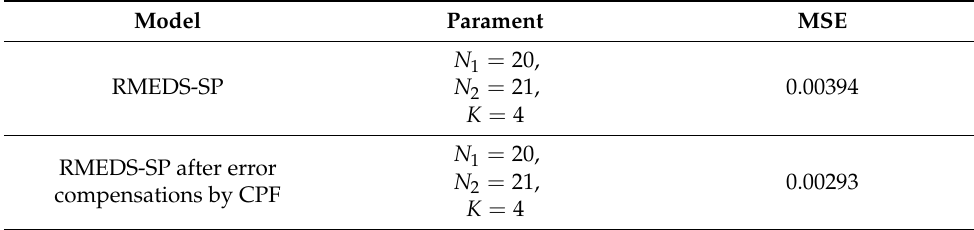
Table 3. ACF analysis after error compensations by